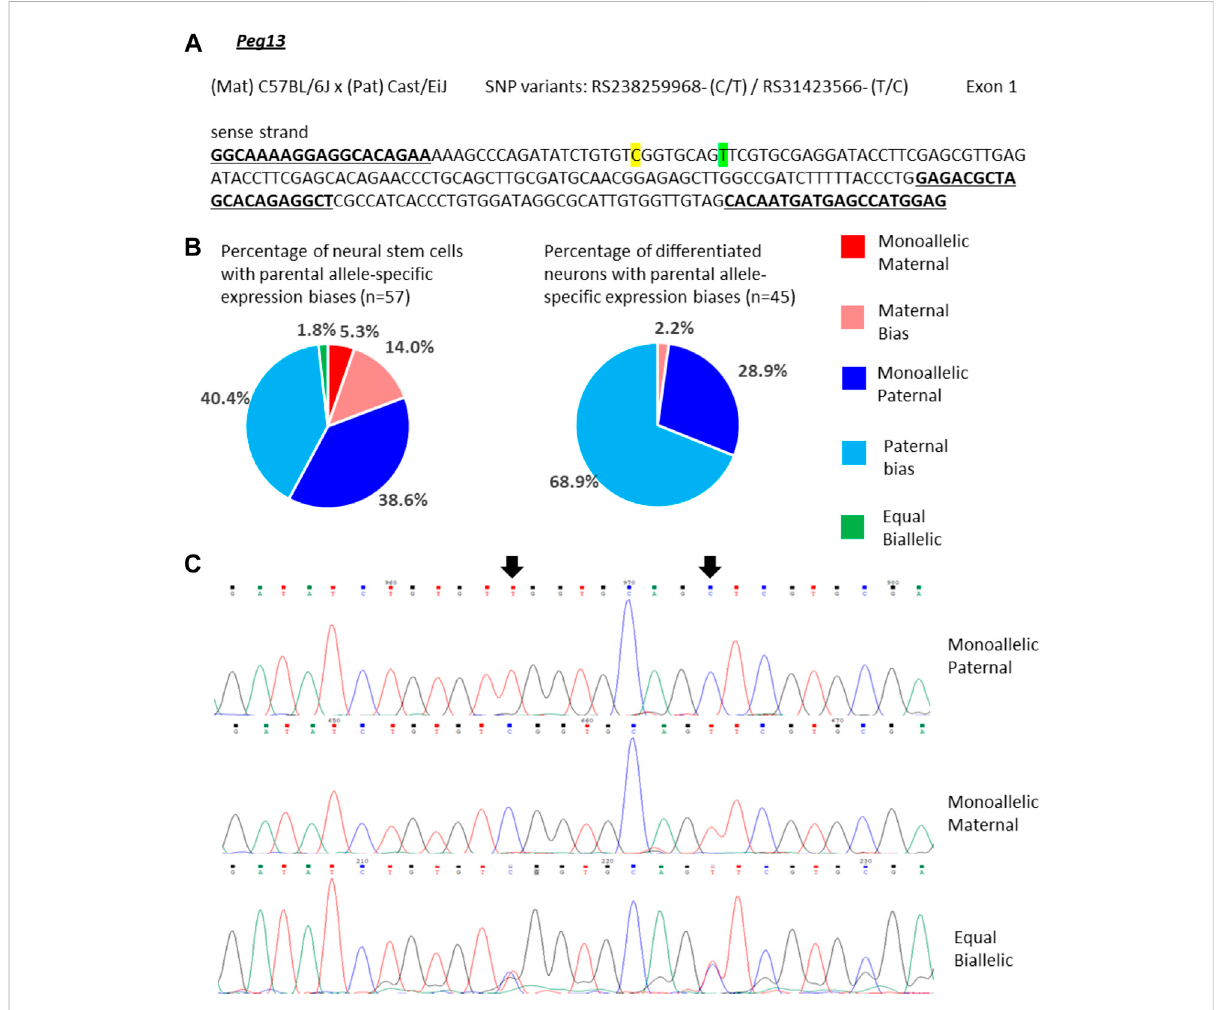
FIGURE 3 Variable single-cell allele-speci fi c expression of Peg13 analyzed through Sanger sequencing of cDNA SNPs from neural stem (neurosphere) cells and their in vitro differentiated neurons. (A) The mouse cross, cDNA amplicon and SNP locations in exon 1 are shown. B6 SNP variants are indicated in color; primers are underlined. (B) Summary data showing the proportions of cells falling into the fi ve categories of allelic expression. (C) Example single-cell sequence tracks for the three expression categories indicated. Sequence tracks for cells with maternal or paternal bias displayed a major SNP peak for those alleles with a minor overlapping SNP peak for the other allele, respectively. SNP positions are highlighted by